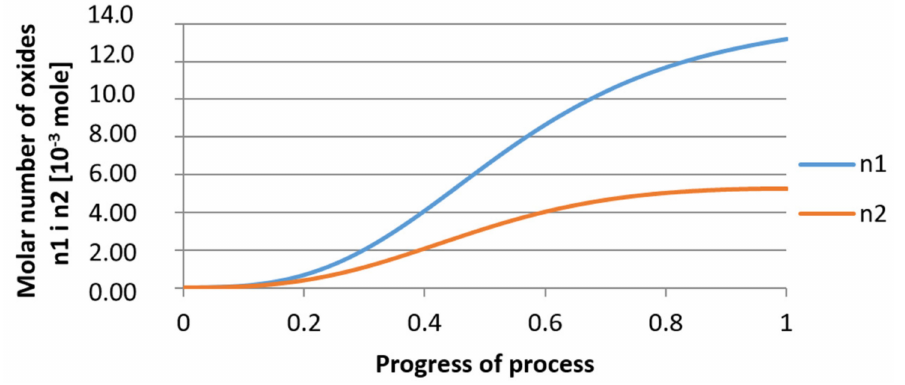
Figure 21. Growth of bi-component nuclei of oxides n 1 (Al 2 O 3 ) and n 2 (Y 2 O 3 ) in steel 2 (for r 0 = 1 µ m).